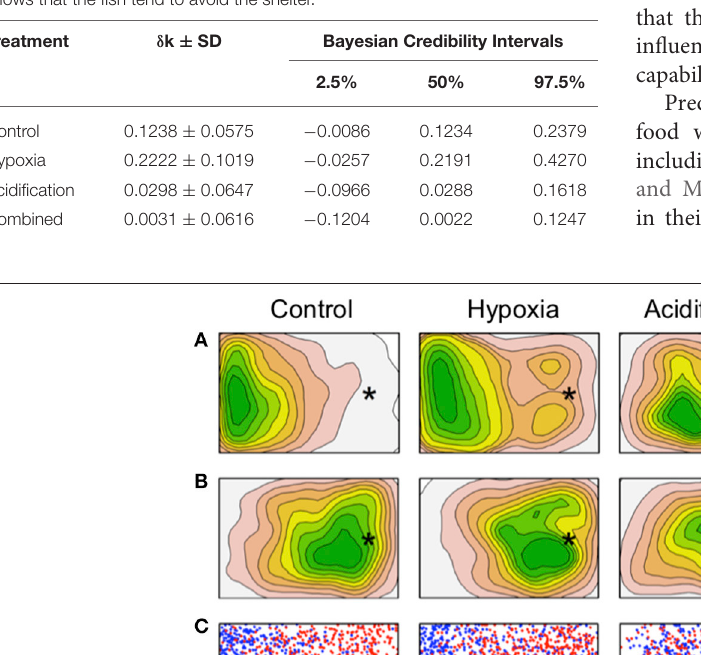
Frontiers in Marine Science |